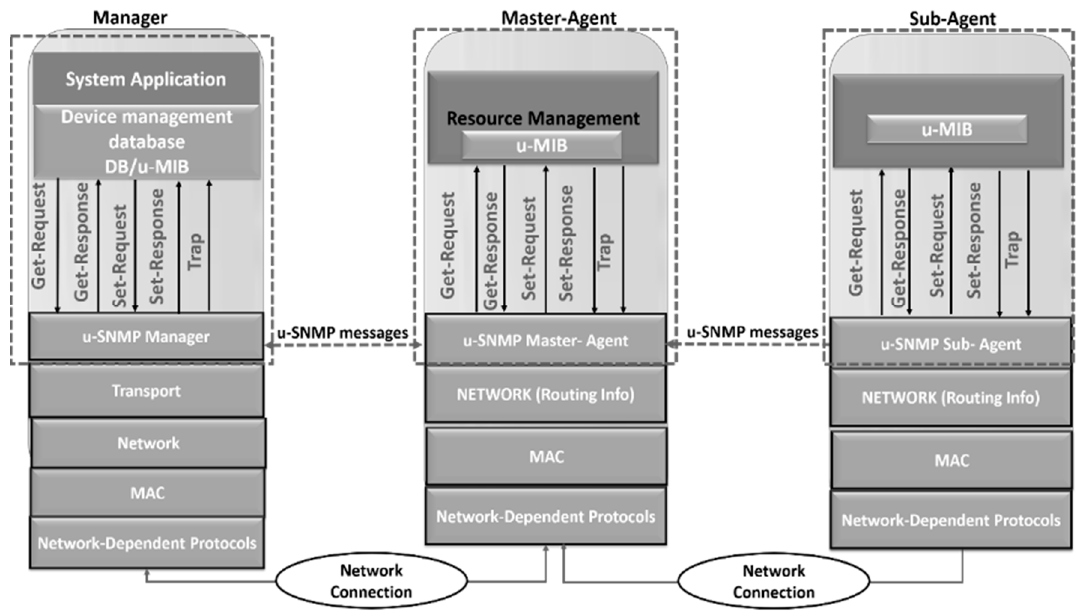
Figure 6. u-SNMP protocol in U-NMS [89]. Table 2. Operations OF u-SNMP [89].